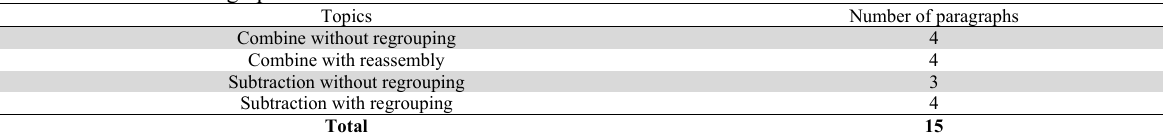
Distribution of Test Paragraphs